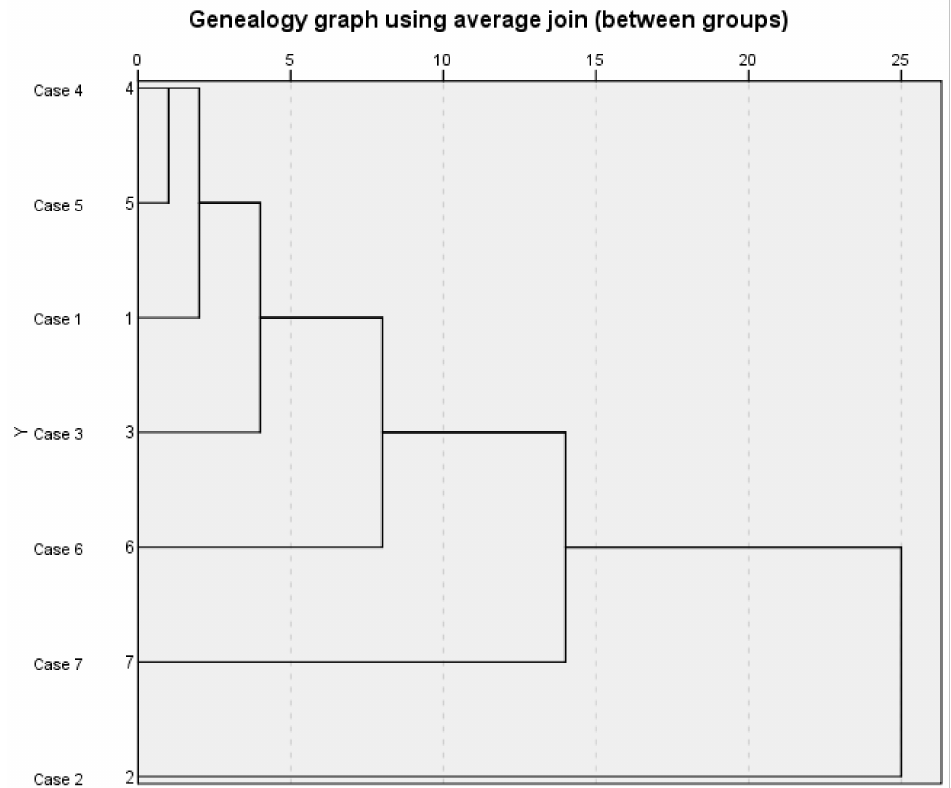
Figure 3. Systematic cluster analysis pedigree of 7 batches of S. chamaejasme flowers samples.